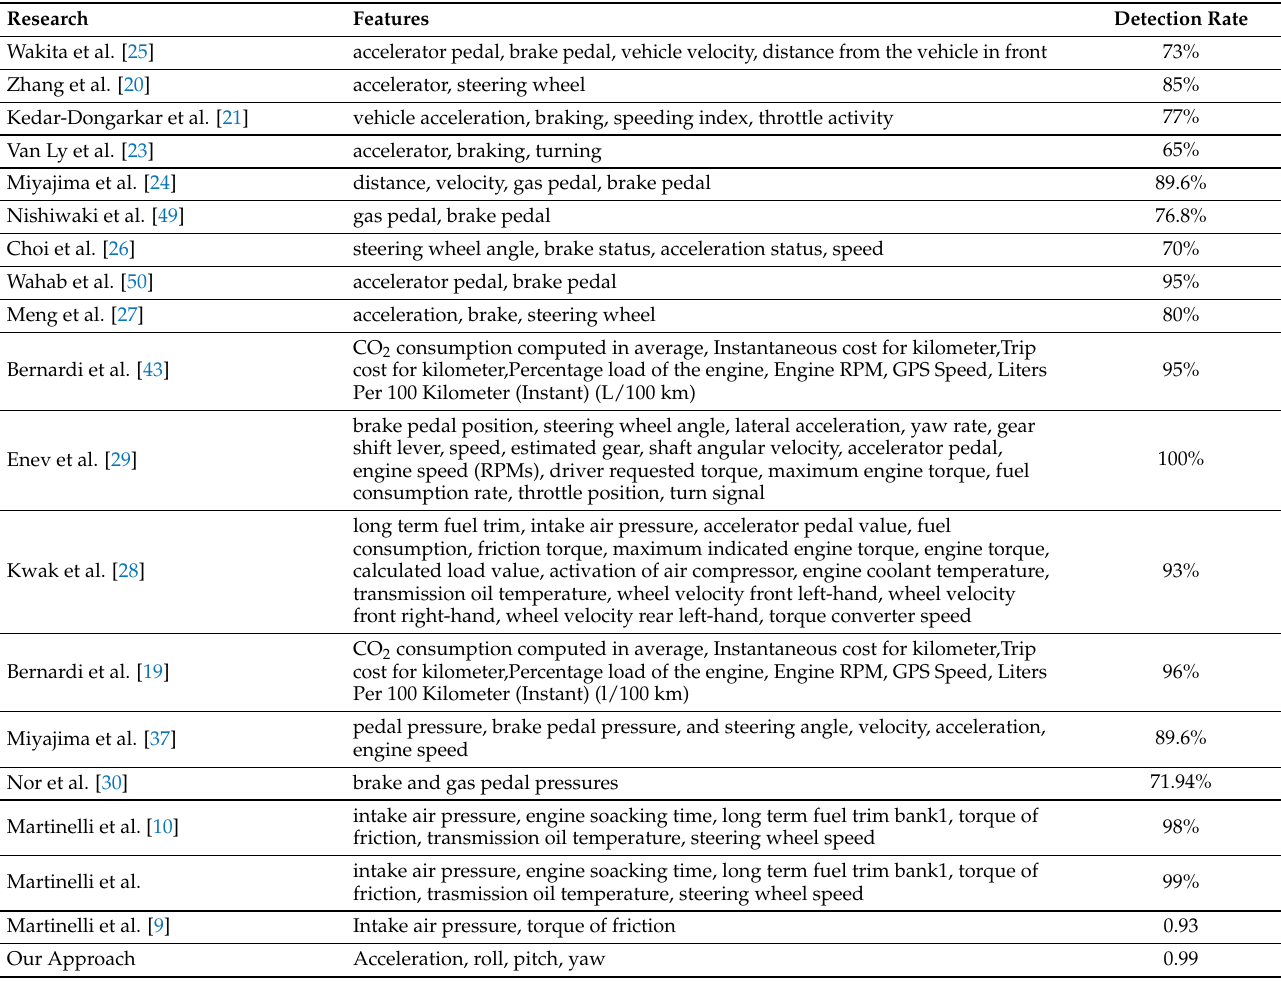
Table 5. Current Literature Comparison on Driver Detection (column Research ) expressed in terms of: features considered (column Features ) and the obtained performances (column Detection Rate